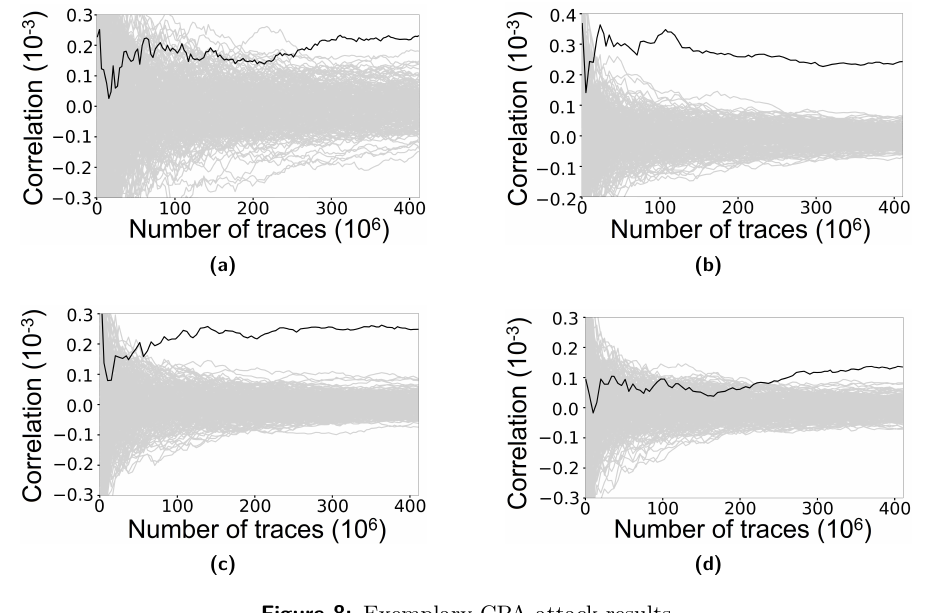
Figure 8: Exemplary CPA attack